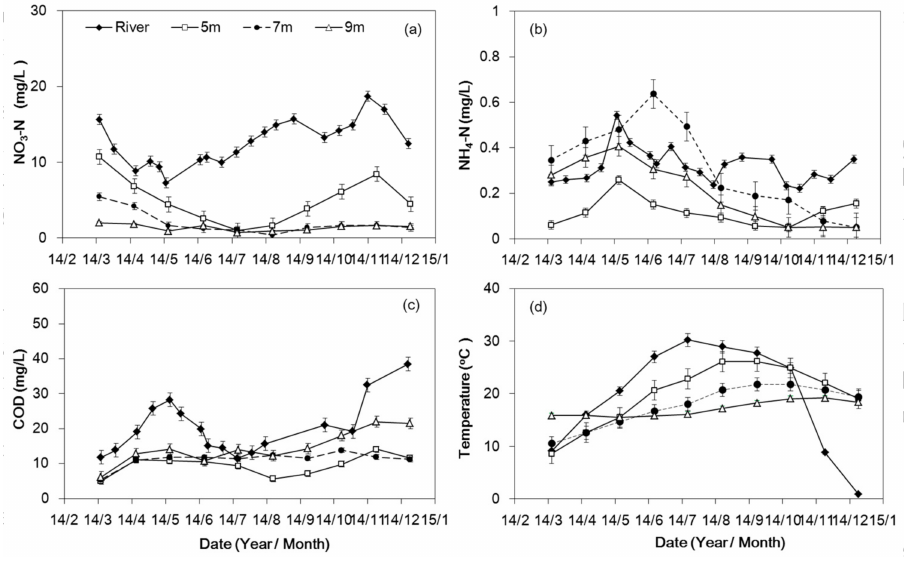
Figure 6. Temporal variations in average NO 3 -N ( a ), NH 4 -N ( b ), chemical oxygen demand (COD) ( c ) and temperature ( d ), in river water and groundwater at depths of 5, 7, and 9 m of SW2 in